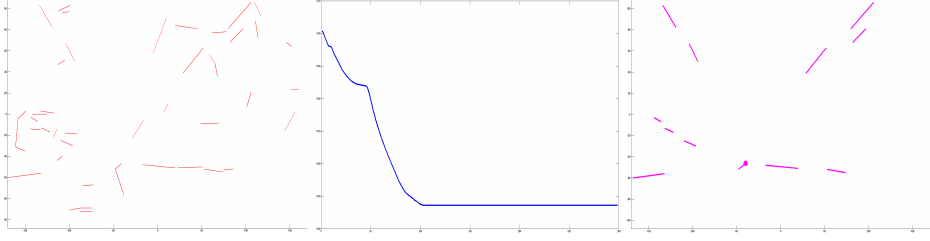
Figure 2. Estimation based on clusters of refined lines. Left column : refined lines. Middle : con- vergence curve in optimal estimation. Right : the pink point is the estimated VP. Based on optimal estimation, the optimal solution can be considered the